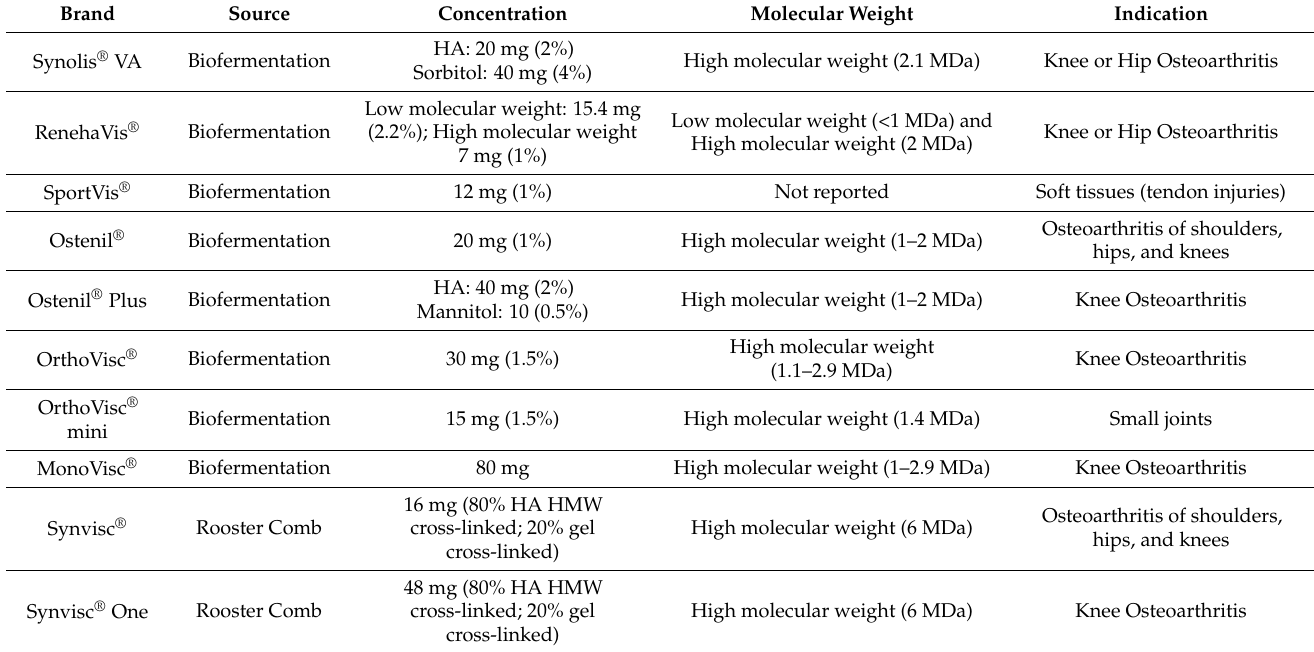
Table 1. Typical hyaluronic acid formulations in